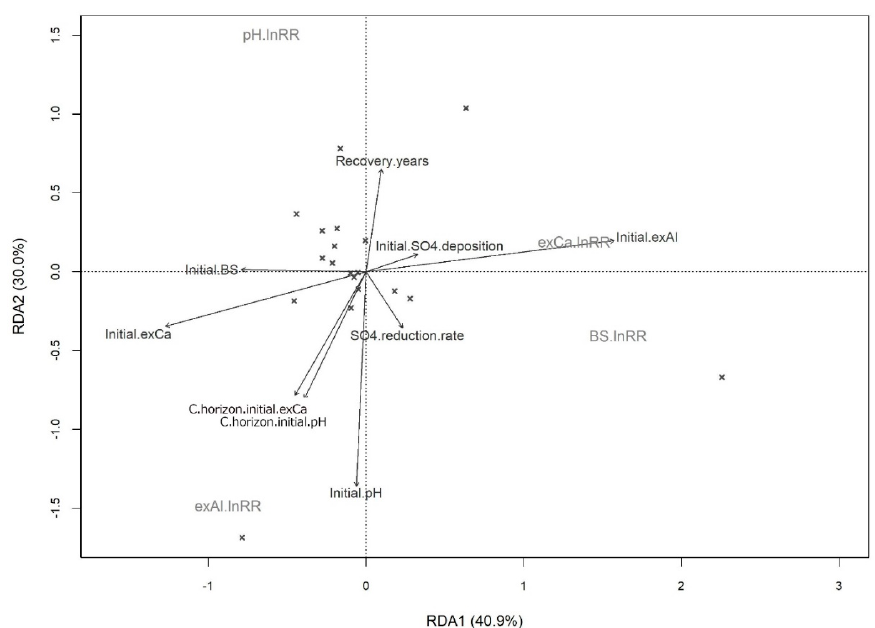
Figure 6. Redundancy analysis showing the relationship between soil recovery indices (light grey) and explanatory variables (black) for the O horizon of 19 soil resampling sites in Eastern Canada and the Northeastern United States. Points (x) represent the soil resampling sites.